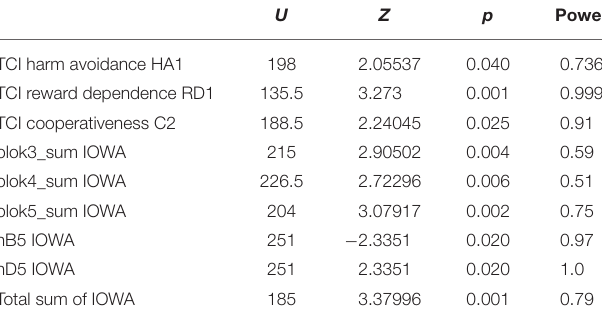
TABLE 4 | Significant differences in the Temperament and Character Inventory (TCI) and the Iowa Gambling Test (IGT) between women and